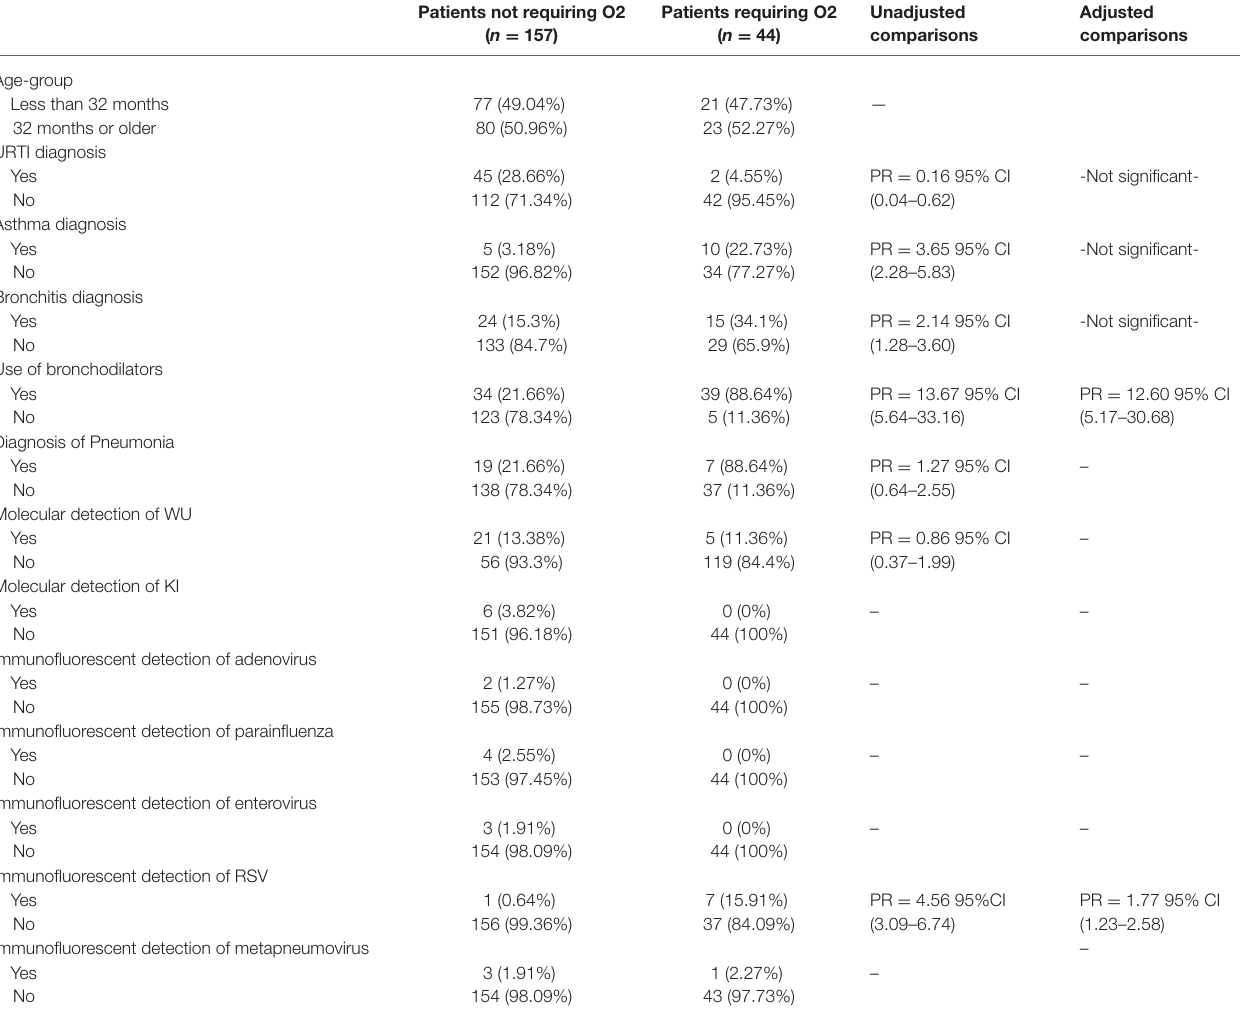
TABLE 2 | Characteristics of 201 pediatric study subjects and an examination of their risk factors for the use of additional oxygen (O2), Singapore December 2016 to April 2017.